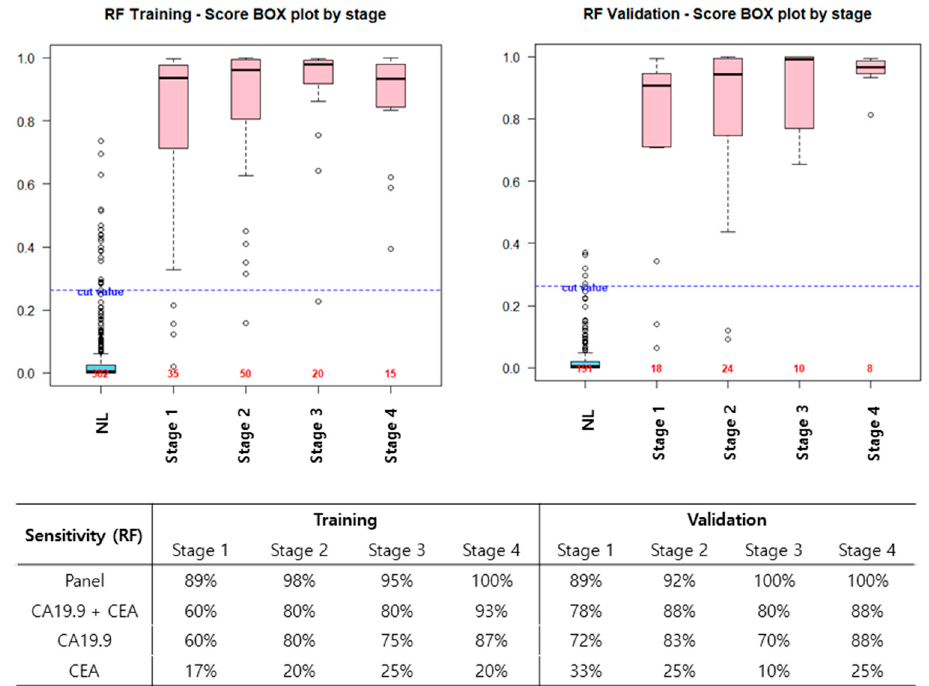
Figure 4. Diagnostic performance, according to the PDAC stage. In the validation set, the diagnostic accuracy, according to the cancer stage was 89%, 92%, 100%, and 100 % in stages 1, 2, 3, and 4, respectively. Notably, in stages 1 and 2, the new model improved the diagnostic ability compared to CA19-9 alone.